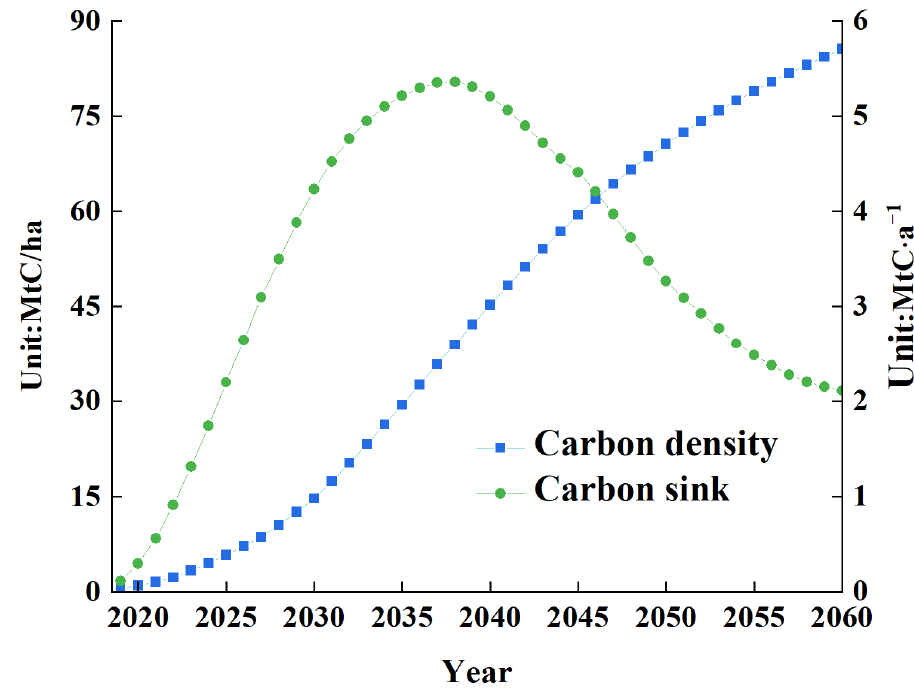
Figure 5. Carbon density and carbon sink of new afforestation in Henan Province, 2019–2060. Figure 6 displays the annual vegetation carbon sinks of newly planted dominant tree species in Henan Province. The annual carbon sinks of these dominant tree species show an inverted U-shaped trend, and the peak carbon sink years of the dominant tree species in new plantations were those of trees that were young or of middle age. Cypress is the largest contributor to the carbon sink of new plantations, and Chinese pine is the lowest. According to the forest-planning objectives of Henan Province, the new forest area in each stage of forest planning was equally distributed amongst each dominant species. Therefore, the main influencing factor of carbon sink in newly planted forests is the carbon density of dominant species. Cypress has the highest carbon density of the dominant species, while poplar and Chinese pine have the lowest carbon densities, respectively. It should be noted that the carbon sink of Chinese pine and poplar changes at different growth stages of the trees. In the early stages of tree growth, the carbon density of poplar is greater than that of Chinese pine, while in the later stages, the opposite is true; this conclusion is also consistent with other scholars’ studies [47,48]. As shown in Figure 6, cypress and Masson pine have higher carbon sinks in the same area, while the rest of the dominant species have lower ones. The existing dominant species in Henan Province are broad-leaved mixed forest, Robur, and poplar in a large area, while cypress and Masson pine have a limited forest area. Based on the perspective of the carbon intensity of the dominant species, the planting of cypress and Masson pine should be increased in the future in order to better achieve the-carbon reduction target of Henan